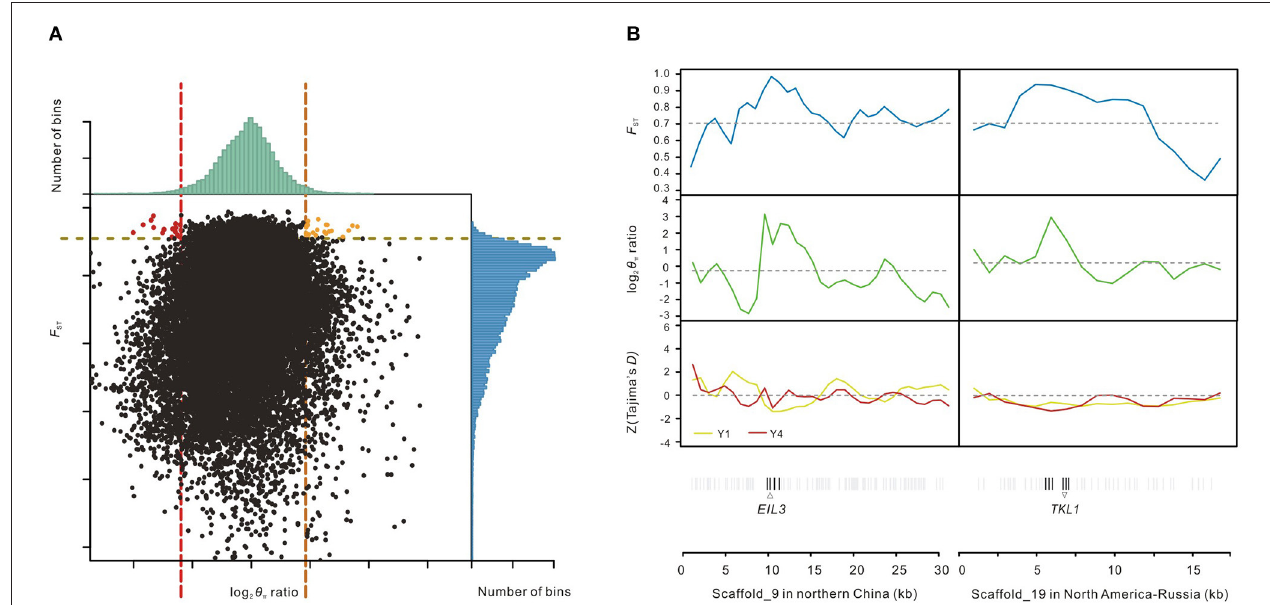
FIGURE 3 | Identification of genomic regions with strong selective sweep signals in northern China and North America-NE Russia. (A) Distribution of log 2 θ π ratios Y1 ( θ π , Y4/ θ π , Y1), Y4 ( θ π , Y1/ θ π , Y4) and F ST of 20kb windows with 10kb steps. Orange and red dots represent windows containing the selected regions of the northern China populations (Y1) and the North America-NE Russia populations (Y4), respectively (corresponding to 5% right tails of θ π ratios distribution and 5% right tail of the F ST distribution). (B) Two scaffolds with strong selection sweep signals in northern China and North America-NE Russia salt cress. F ST , log 2 θ π ratios and Tajima’s D values are plotted using a 20kb sliding window with 10kb steps. Horizontal dashed lines represent mean whole-genome of corresponding values. Genes are shown at the bottom (black lines represent the putatively selected genes); Pale gray lines represent the other